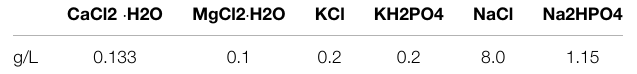
TABLE 1 | Salt concentration of Dulbecco ’ s Phosphate Buffered Saline solution. CaCl2 ·